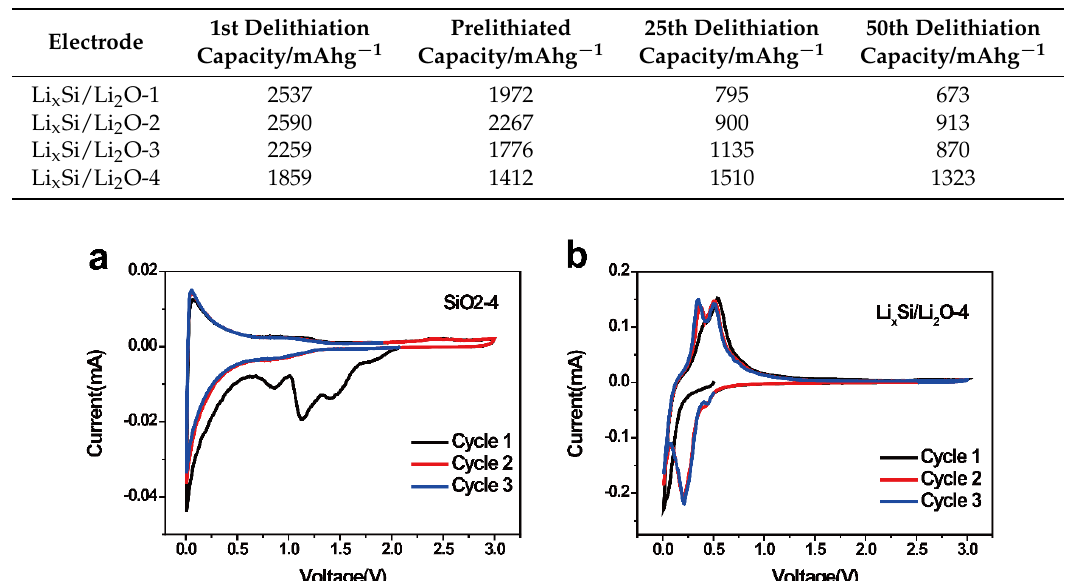
Figure 4. Cycling voltammetry measurement of SiO 2 electrodes before ( a ) and after ( b ) prelithiation. Table 1. Cycling performance for Li x Si/Li 2 O electrodes.